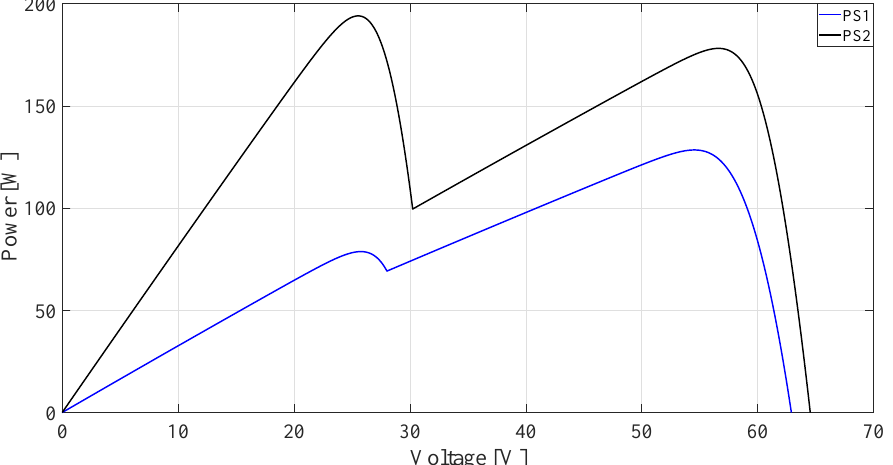
Figure 14. Different cases of partial shading based on Matlab/Simulink PV emulator.